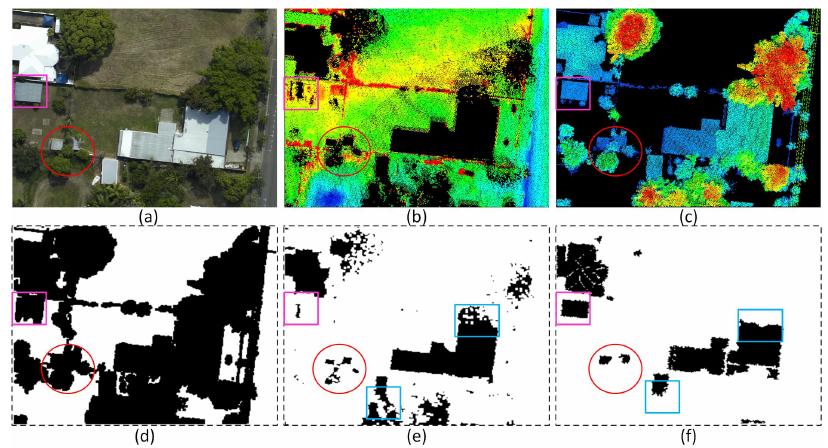
Figure 1. A complex scene: (a) aerial image, (b) ground points, (c) non-ground points, (d) normalised-DSM generated from the non-ground points, (e) primary mask generated from ground points and (f) proposed building mask generated from non-ground points.